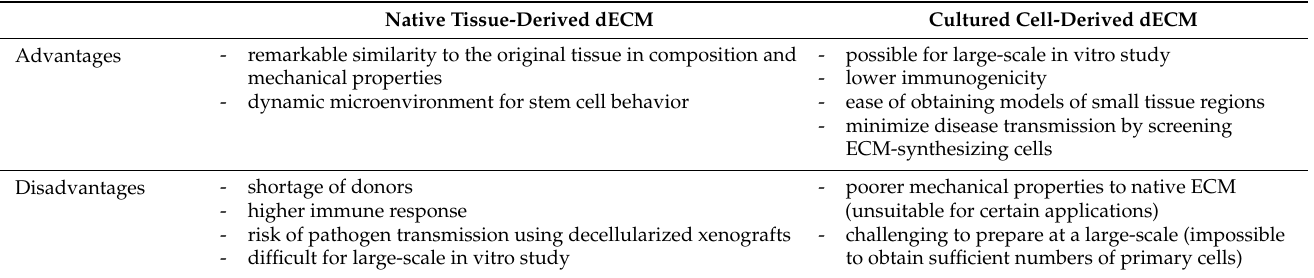
Table 1. Comparison between native tissue-derived dECM versus cultured cell-derived